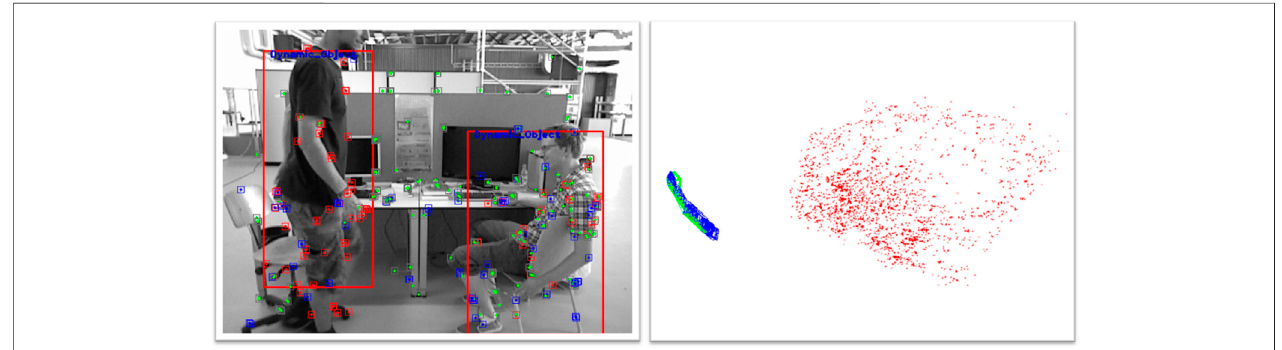
FIGURE 5 | Improved algorithm for current frame window with sparse point cloud